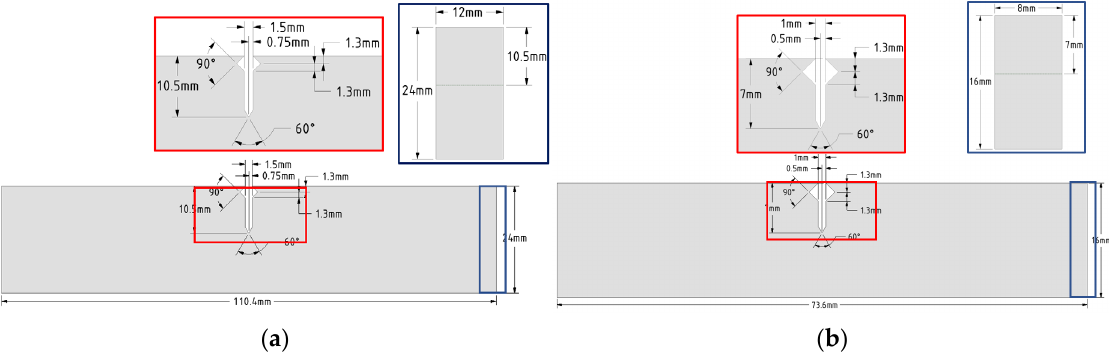
Figure 4. Detailed dimensions of CTOD test specimens: ( a ) high Mn; ( b ) 9% Ni.